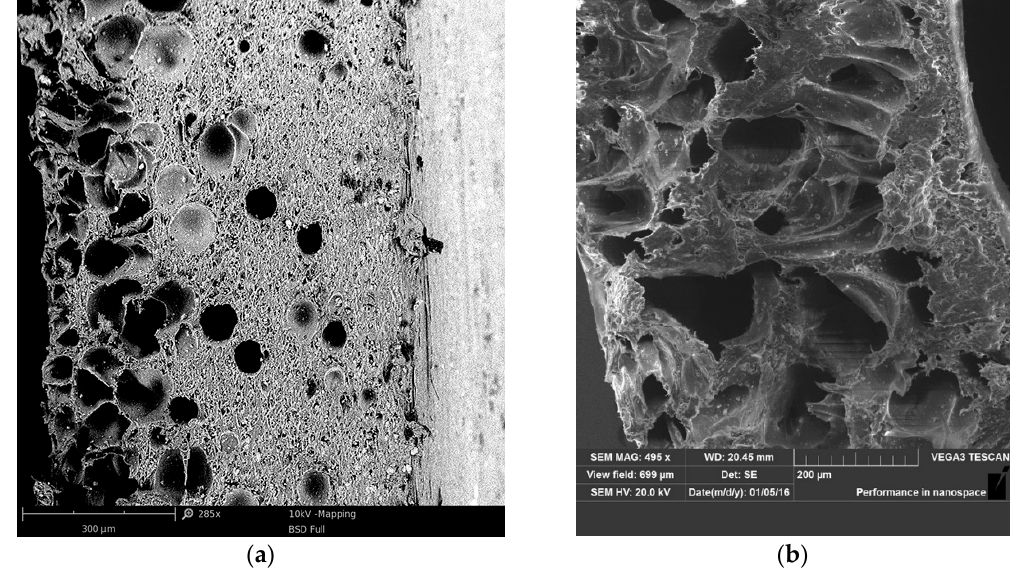
Figure 7. Scanning electron micrographs of the PVC single coatings: ( a ) PVC + 0.2% BA; ( b ) PVC + 0.6% BA.